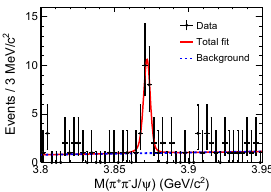
Figure 2. The fit to σ B [ e + e − → γ X (3872)] × B [ X (3872) → π + π − J /ψ ] with a Y (4260) reso- nance, a linear continuum, or a E 1-transition phase space